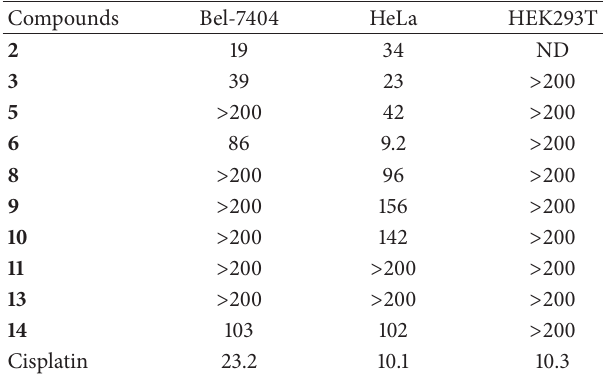
Scheme 3: Synthesis of methyl 7-deoxycholate complex 14 . Table 1: Cytotoxicity a of steroidal thiosemicarbazones and their Pt- complexes in vitro (IC 50 : 𝜇 M) b